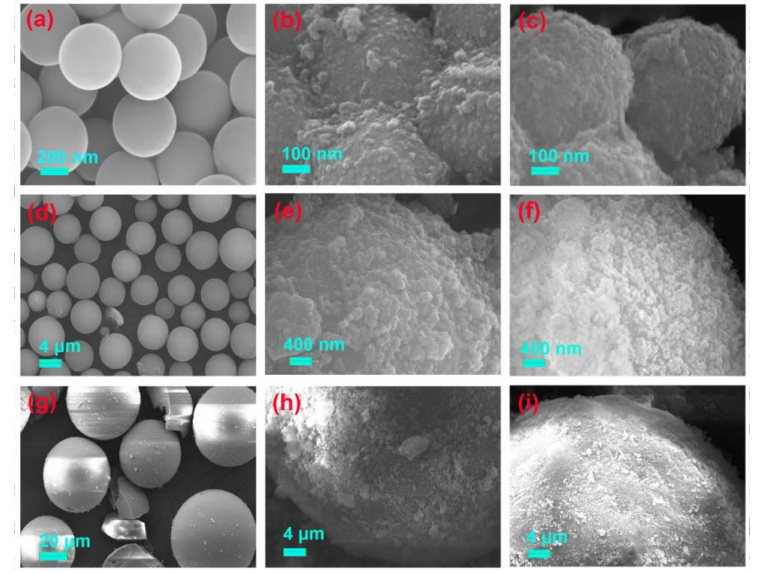
Figure 3. SEM images of silica support and its corresponding NIP and MIP ( a ) spherical 0.5 µ m silica, ( b ) spherical 0.5 µ m silica-NIP and ( c ) spherical 0.5 µ m silica-MIP; ( d ) spherical 5 µ m silica, ( e ) spherical 5 µ m silica-NIP and ( f ) spherical 5 µ m silica-MIP; ( g ) spherical 60 µ m silica, ( h ) spherical 60 µ m silica-NIP and ( i ) spherical 60 µ m